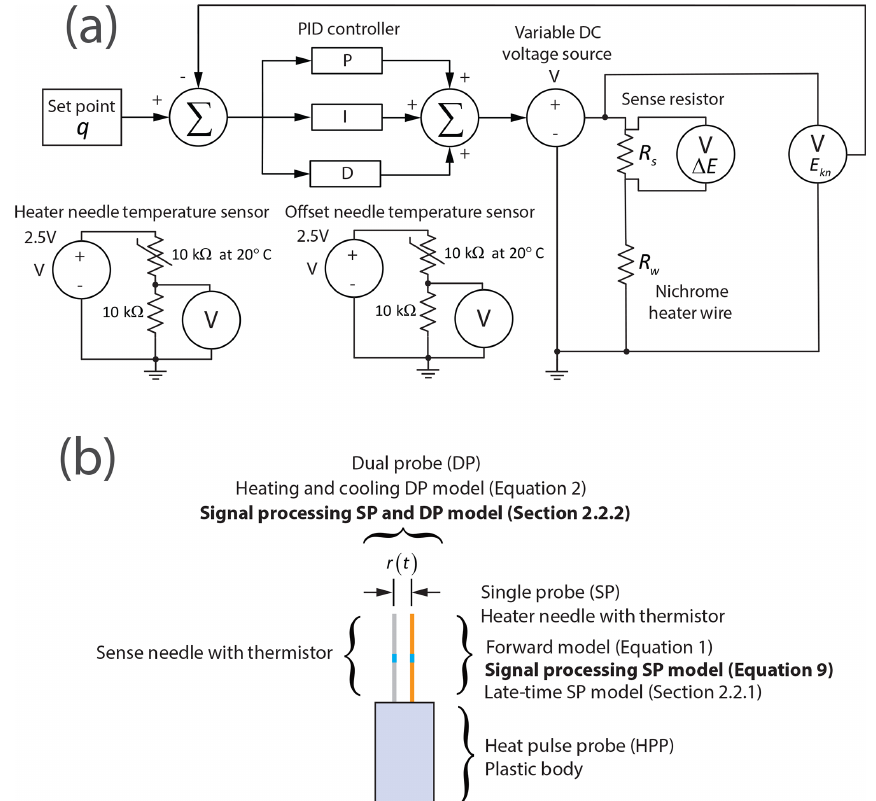
Figure 1. (a) Conceptual block diagram of the HPP system. The set point q and the PID controller ensure a constant input of heat into the soil over the length of the heater needle. The PID controller modulates heat inputs by changing the output of a variable DC voltage source, and the feedback path is shown. A Kelvin-connection sense resistor measures the current through the nichrome heater wire. A reduction in voltage over the sense resistor element is (cid:49)E , and the ground-referenced output voltage through the nichrome wire is E kn . The heater needle temperature sensor and offset needle temperature sensor circuits are also shown. A constant voltage source of 2.5V is connected to a half-bridge. One element of the bridge is a thermistor with a nominal resistance of 10k (cid:127) specified at a temperature of 20 ◦ C, and the other is a precision resistor with a fixed resistance. (b) Conceptual diagram showing relationships between models and heat pulse probe (HPP) measurements for the hybrid single and dual probe. Each model in the diagram is described in the associated text. Model text in bold indicates signal processing introduced in this paper. The r(t) indicates a time-variable effective